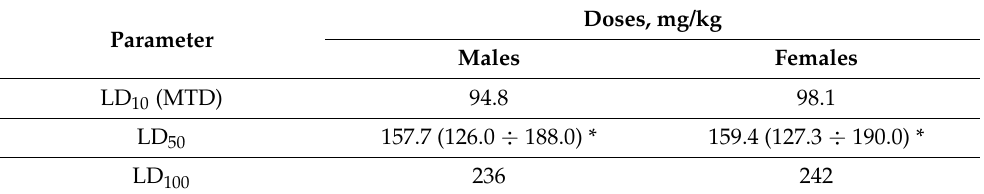
Table 2. Quantitative parameters of acute toxicity of flavancin in rats ( n =